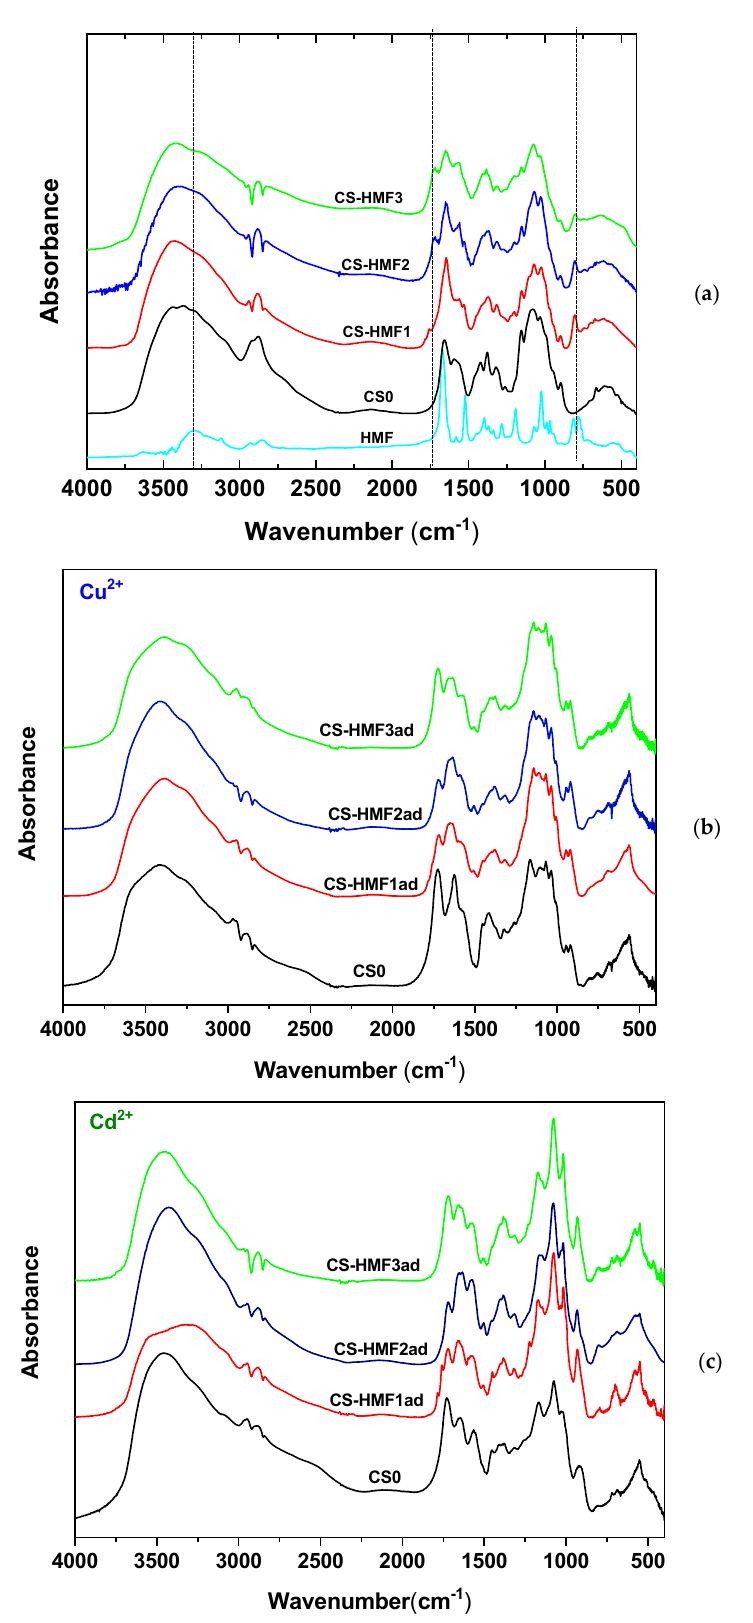
Figure 6. FTIR spectra of the synthesized chitosan derivatives; ( a ) before adsorption; ( b ) after Cu 2 +